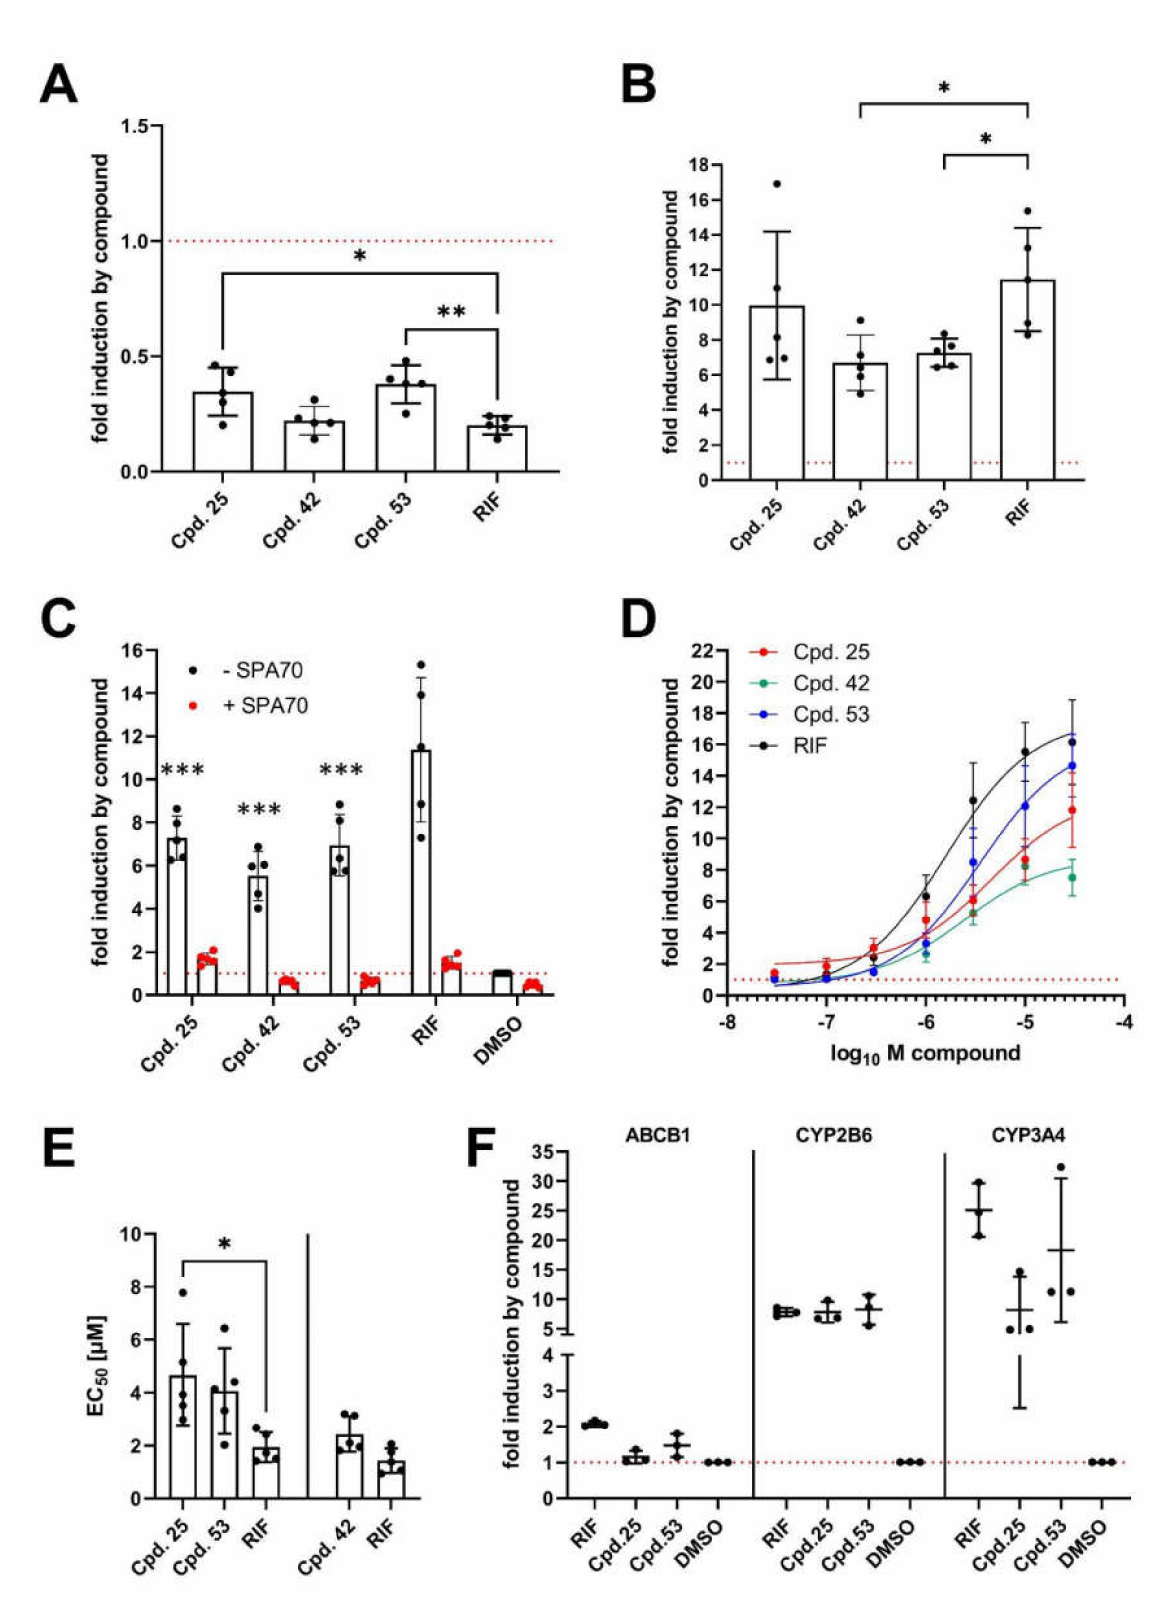
Figure 7. Characterization of novel PXR effectors by analysis of co-factor interaction assays, CYP3A4 reporter gene activation and induction of endogenous PXR target genes. ( A,B ) HepG2 cells